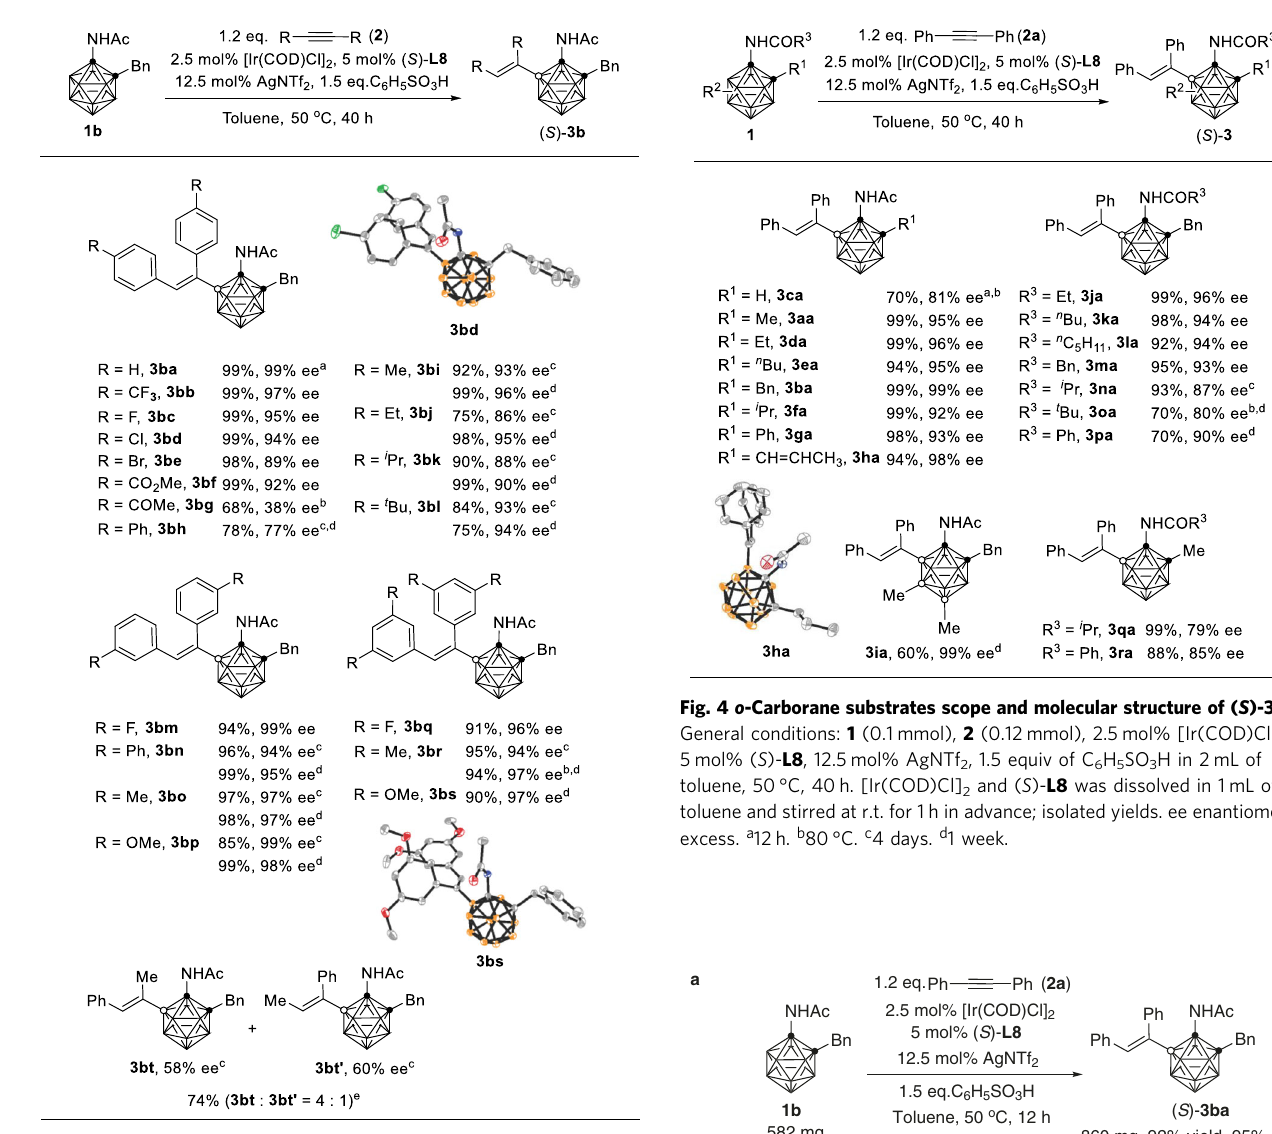
Fig. 3 Alkyne substrates scope and molecular structures of ( S )-3bd and ( S )-3bs. General conditions: 1b (0.1 mmol), 2 (0.12 mmol), 2.5